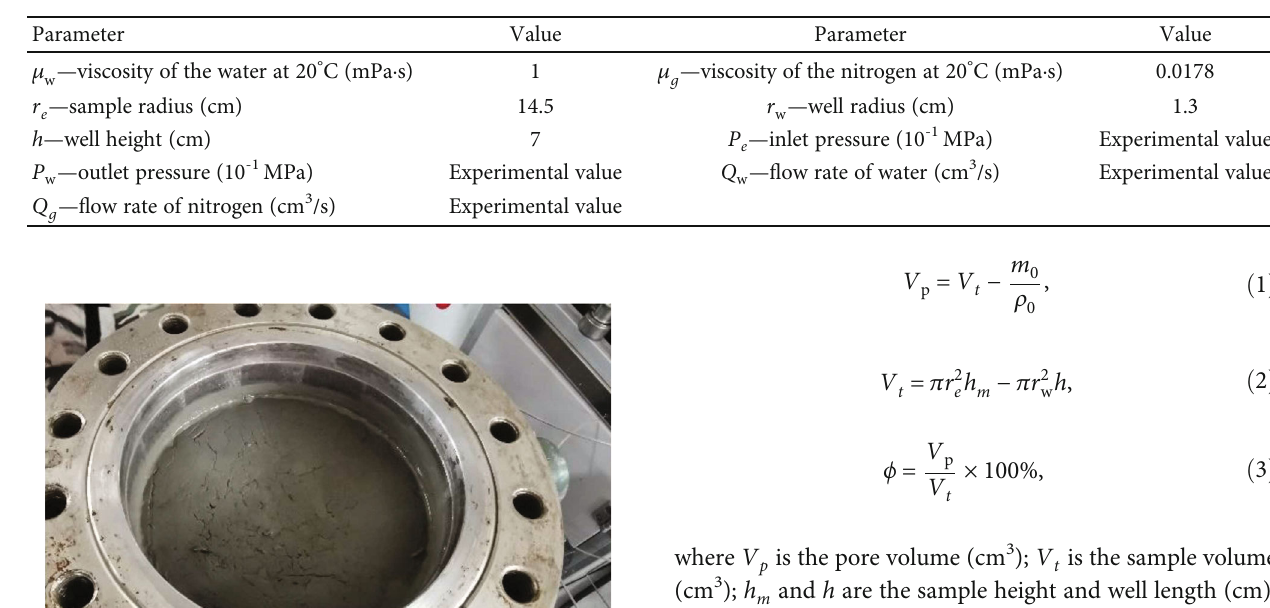
Figure 1: Experimental system. Table 1: Experimental parameters.